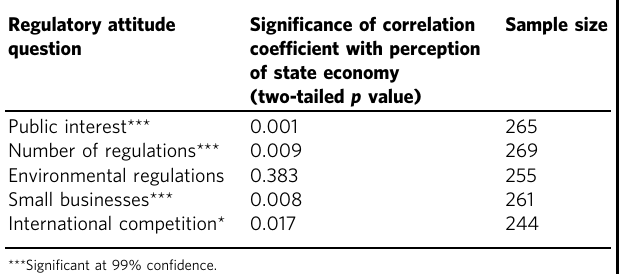
Table 5 Correlation between economic and regulatory